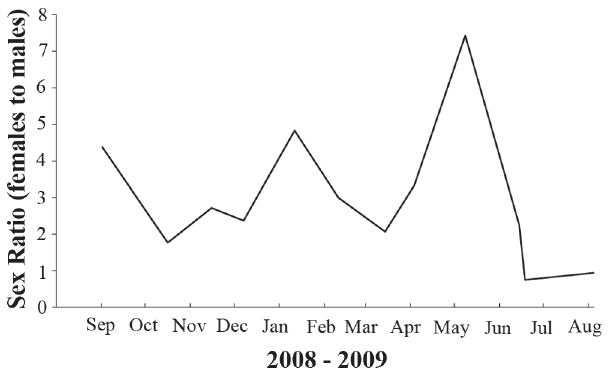
Fig. 2. Monthly variation in the sex ratio (females to males) of Anableps anableps in the mouth of the Maracanã River, Pará